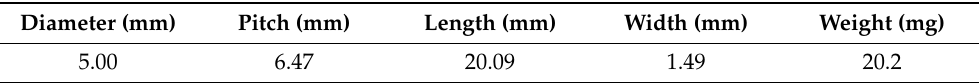
Figure 1. ( a ) Fabrication process of the helical IPMC; ( b ) a photograph of the specimen. Table 1. Parameters of the helical IPMC Table 1. Parameters of the helical IPMC specimen.